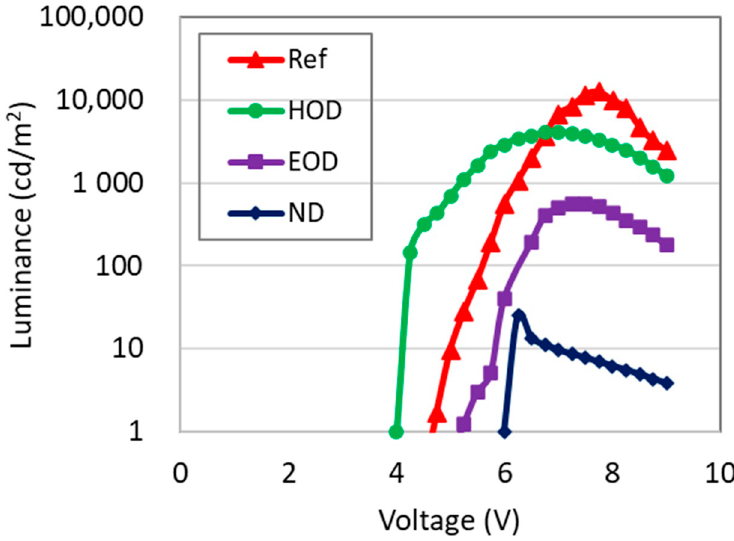
Figure 4. Luminance for the test devices employed for the emission profiling study.